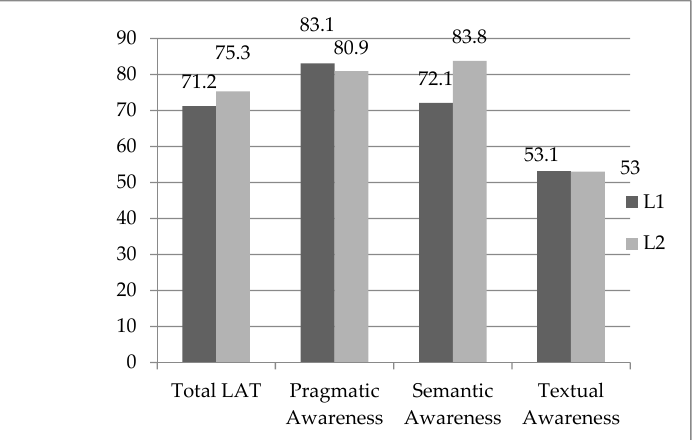
Figure 2. LAT scores in L1 and L2.